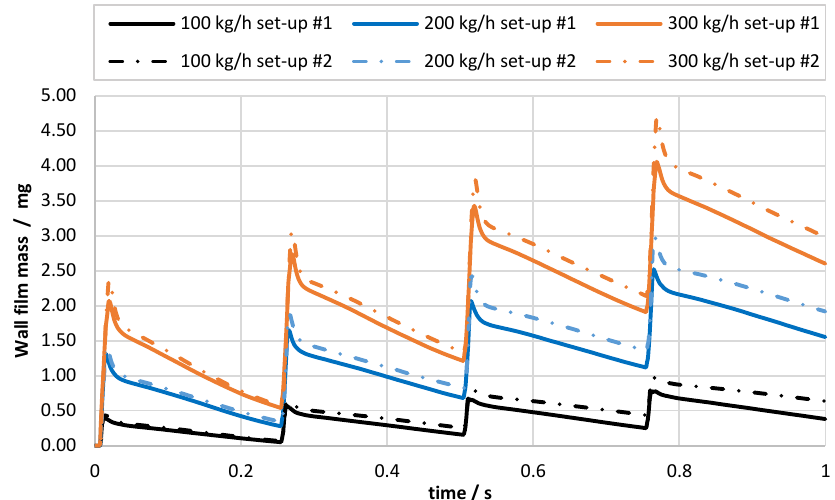
Figure 11. Wall film mass evolution for different exhaust gas mass flow and different simulation set-ups; set-up #1 was based on UWS experimental data, set-up #2 was based on water experimental data.